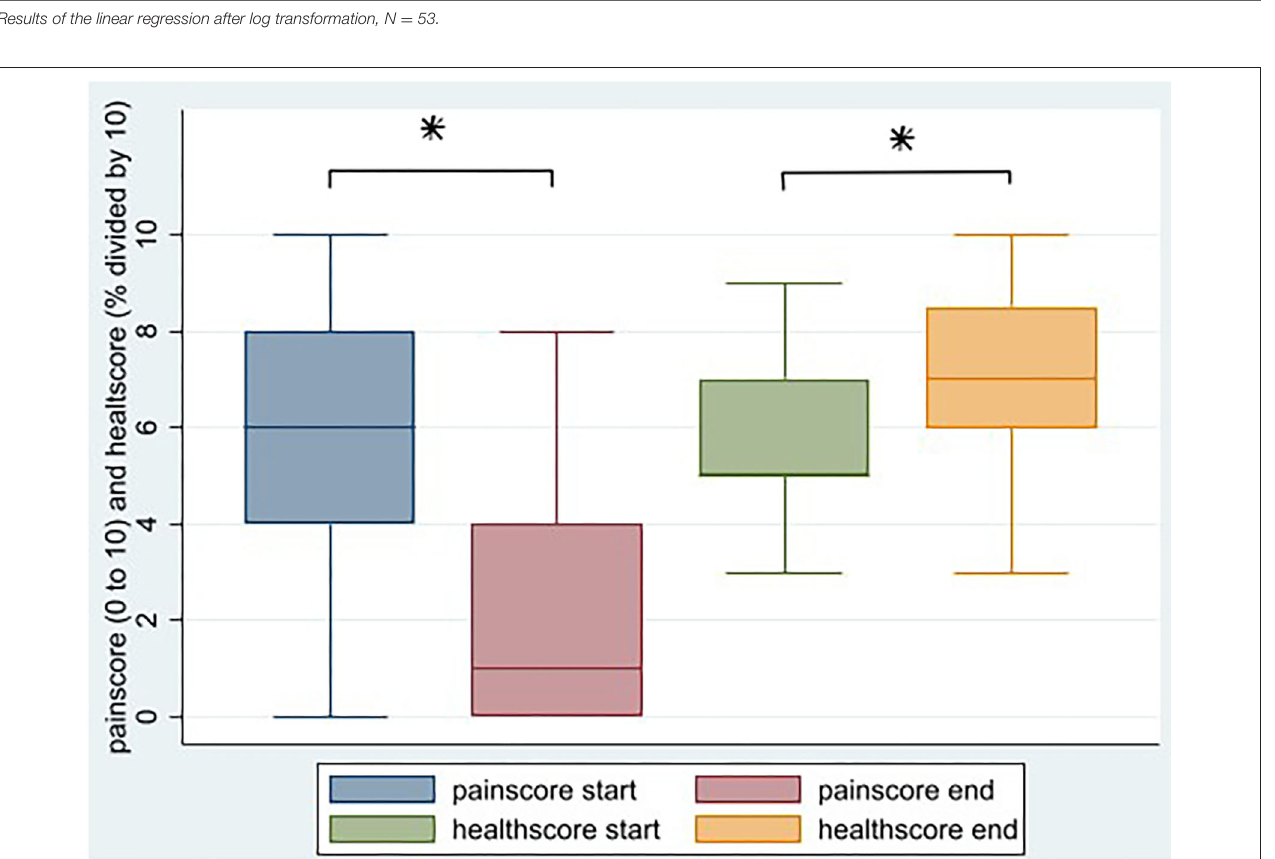
( Table 3 ). Regression analysis with the percentual size reductions did not reveal an association with wound duration. However, these results were not statistically significant, probably due to the low number of patients in the lower categories, impeding statistical